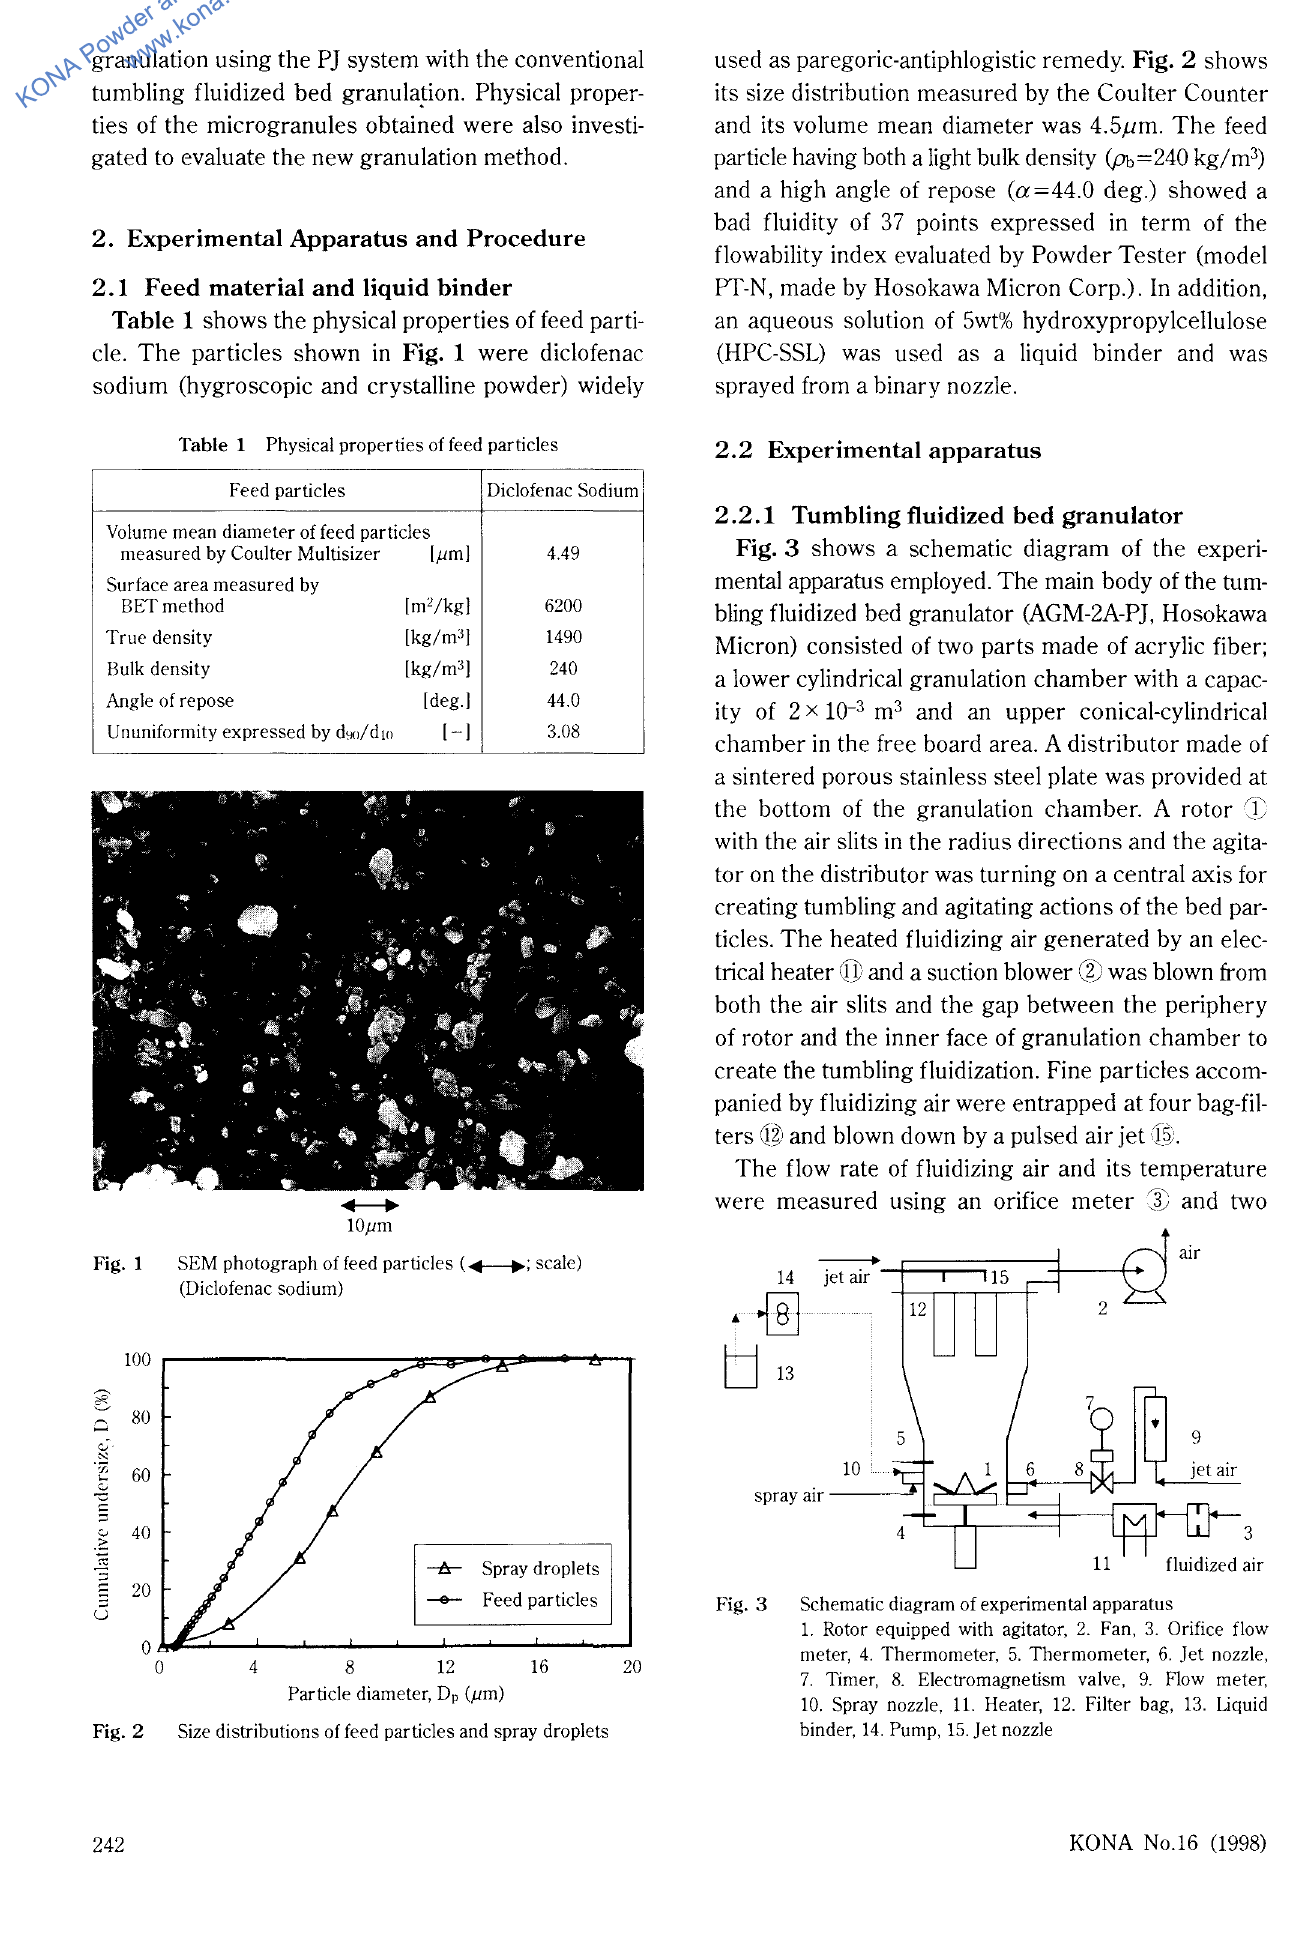
Schematic diagram of experimental apparatus 1. Rotor equipped with agitator, 2. Fan, 3. Orifice flow meter, 4. Thermometer, 5. Thermometer, 6. Jet nozzle, 7. Timer, 8. Electromagnetism valve, 9. Flow meter, 10. Spray nozzle, 11. Heater, 12. Filter bag, 13.